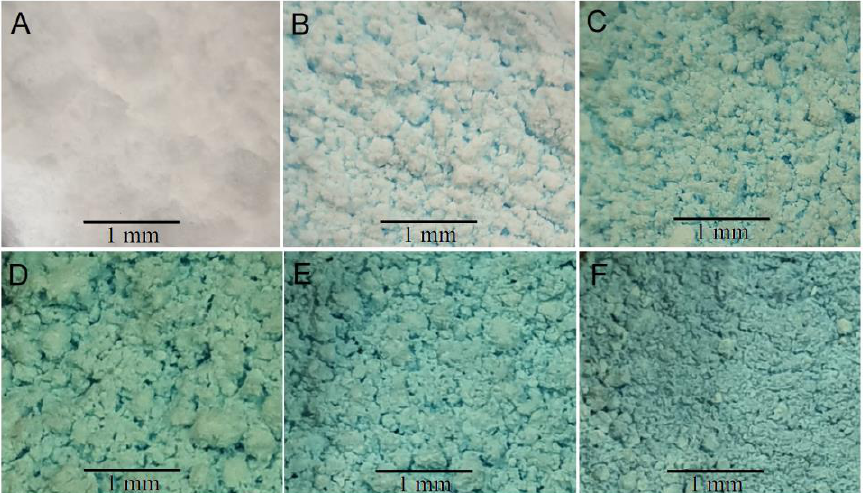
Figure 3. Images obtained by optical microscopy (Optika, Italy) of Ca-Cu phosphates, ( A ) BCu0, ( B ) BCu1, ( C ) BCu4, ( D ) BCu5, ( E ) BCu6, and ( F ) BCu10 (all images have the same 1 mm scale bar).